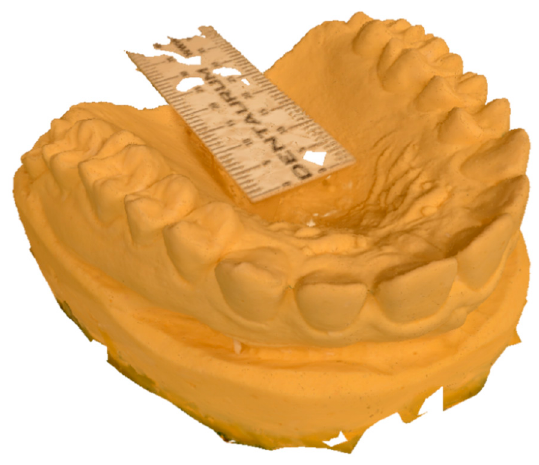
Figure 3. Dense point cloud.